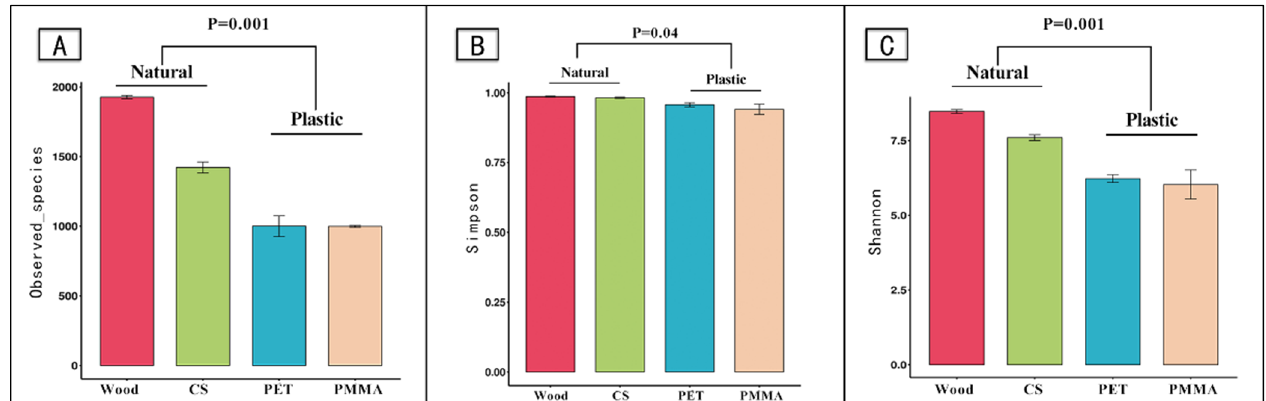
Figure 3. Different alpha diversities, including observed_species ( A ), varies from 999 to 1927, Simpson ( B ), varies from 0.941 to 0.986 and Shannon index ( C ), varies from 6.03 to 8.48 of biofilm bacterial communities on wood, cobble stones (CS), polyethylene terephthalate (PET) and polymethyl methacrylate (PMMA).